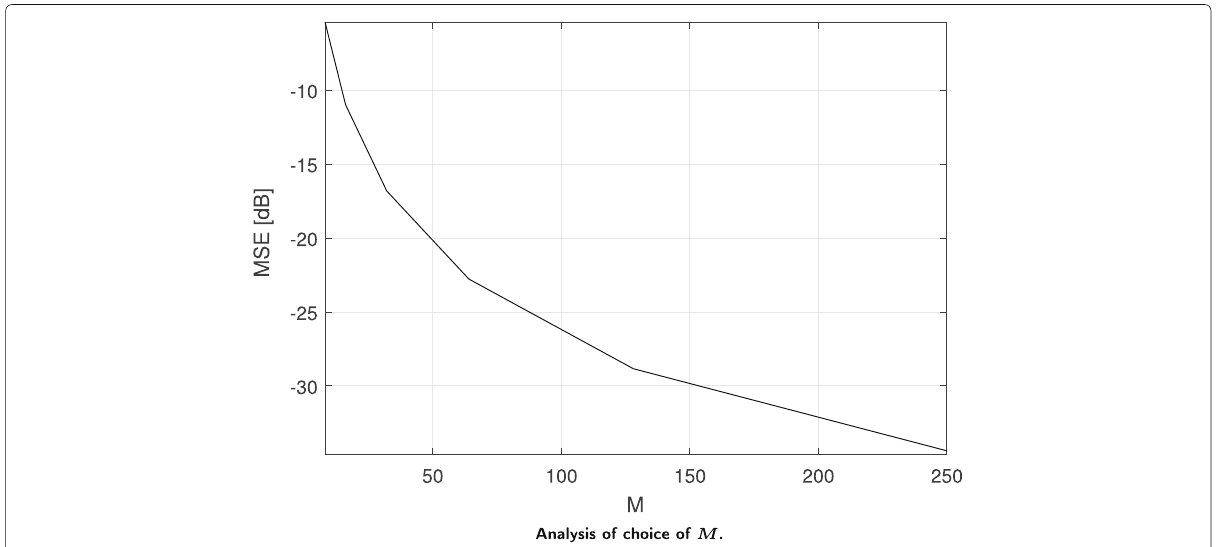
Fig. 5 Analysis of choice of M . MSE vs M = M 1 = M 2 for the scenario of Appendix B, with N t = 16 and N r = 4